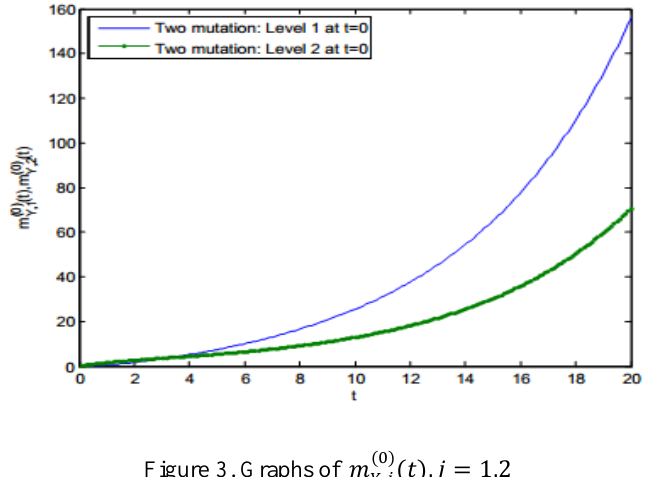
Figure 3. Graphs of 𝑚 𝑌,𝑗(0) (𝑡), 𝑗 = 1,2